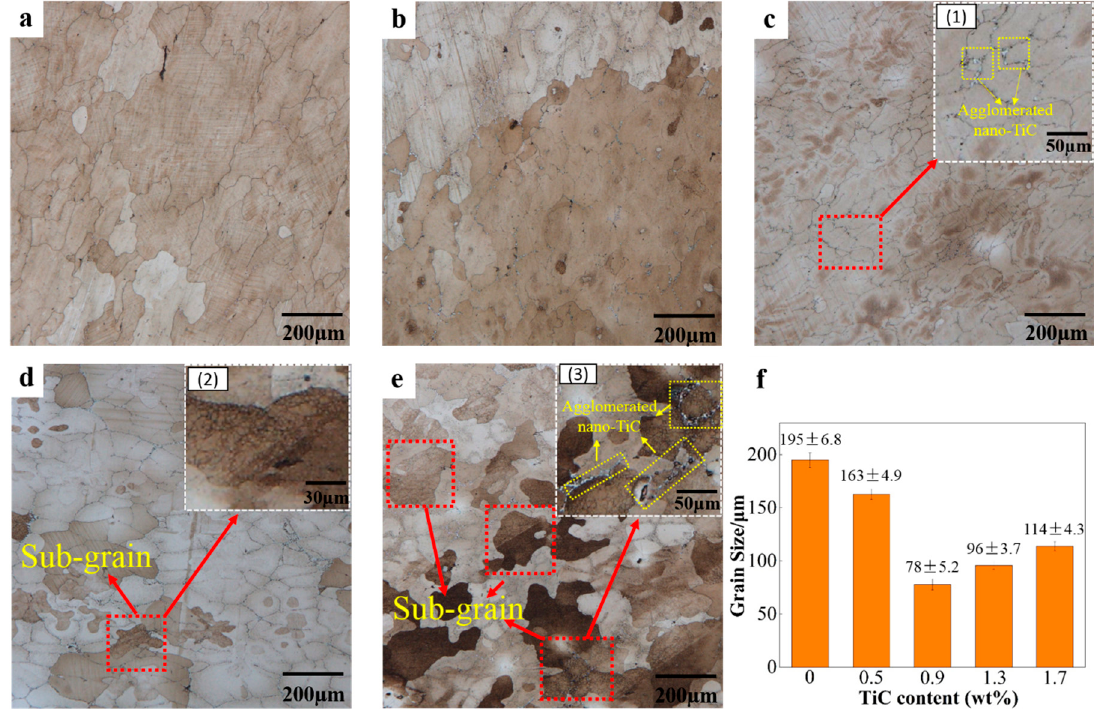
Figure 3. Optical microscopy (OM) images of forged and heat-treated TiC / 2219 nanocomposites with different nanoparticle contents: ( a ) 0 wt.%, ( b ) 0.5 wt.%, ( c ) 0.9 wt.%, ( d ) 1.3 wt.%, and ( e ) 1.7 wt.%. Inset (1) and (2) present the agglomerated TiC nanoparticles along the grain boundaries and sub-grains, respectively, and (3) represents the serious nanoparticle agglomeration along the grain boundaries; ( f ) is the average grain size of the TiC / 2219 nanocomposites.